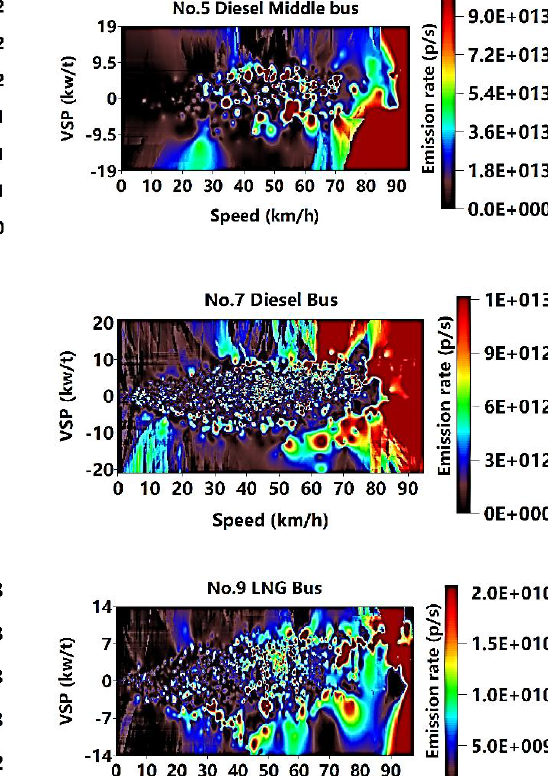
Figure 4. The image maps of the relationship between speed-VSP and NOx emission rates. NOx emission rates are represented by the colors. The black, brown, blue, cyan, green, yellow, orange, red, and ruby red areas indicate that the emission rates are approximately 0, 0.5, 1, 1.5, 2, 2.5, 3, 3.5, and over 4 times the average emission rate, respectively. Speed is at the X-axis, and VSP is at the Y-axis.